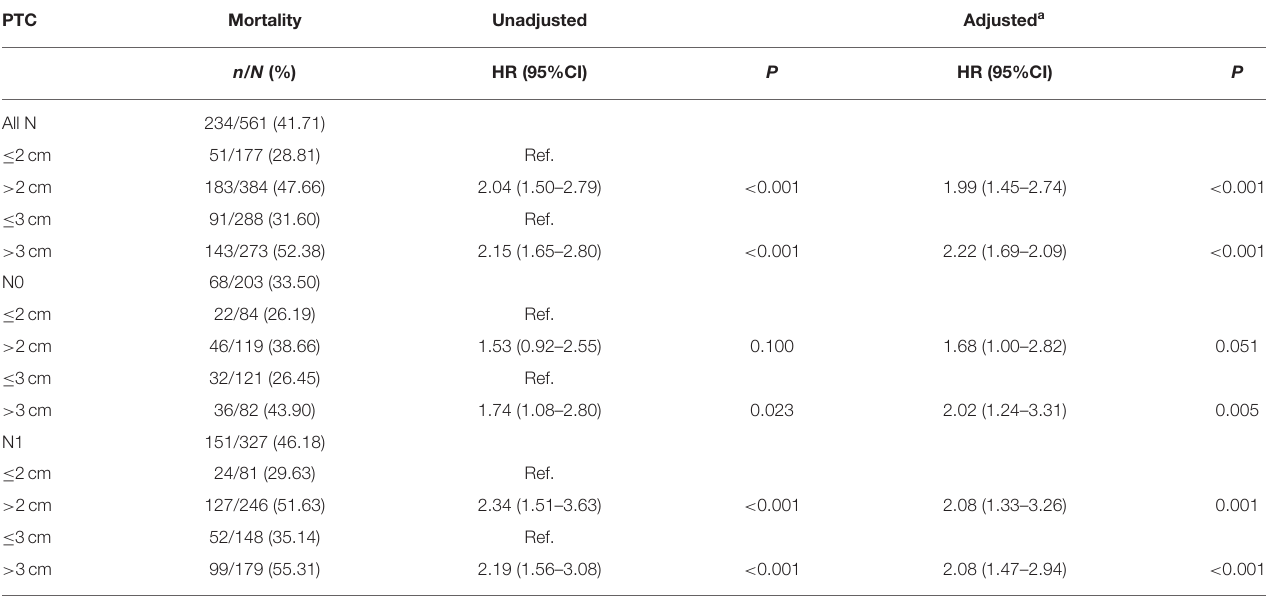
TABLE 4 | The threshold of tumor size concerning thyroid cancer specific mortality in papillary thyroid cancer patients with different N category (SEER database years of 2004–2016).